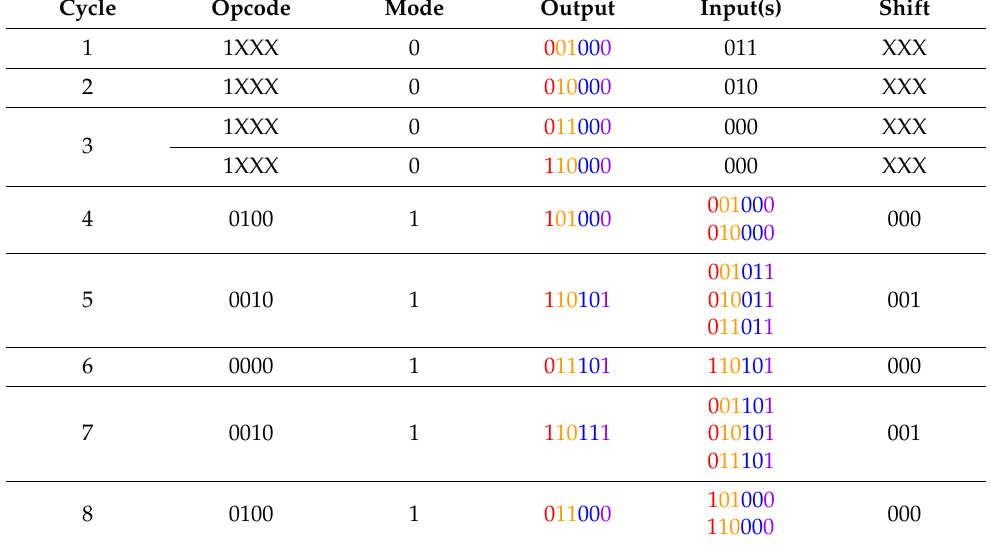
Table 4. Form of instructions executed to perform the binary addition. Colors in the values given for input/output addresses designate the different fields of the address code in Figure 9a. X means a don’t care